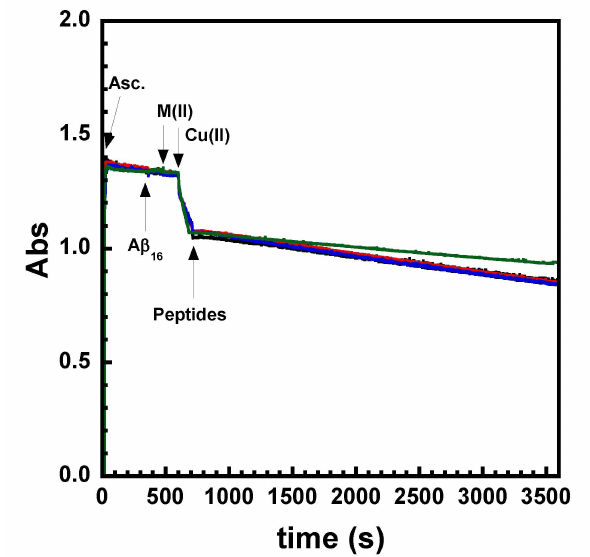
Figure 4. Ascorbate consumption (measured at λ = 265 nm) as a function of time. Ascorbate was added first, followed by A β at 6 min, Zn II (green), Mg II (blue), Ca II (red), and no ions (grey) at 10 equiv. versus Cu II at 8 min, and Cu II at 10 min, and, finally, the AHH peptide when an absorbance of 1.2 was reached. Measurements were performed in 50 mM HEPES buffer (pH 7.5) at 25 ◦ C with continuous stirring. Final concentrations: [Asc] = 100 µ M, [A β ] = [peptide] = 12 µ M, [Cu II ] = 10 µ M, [Zn II ] = [Ca II ] = [Mg II ] = 100 µ